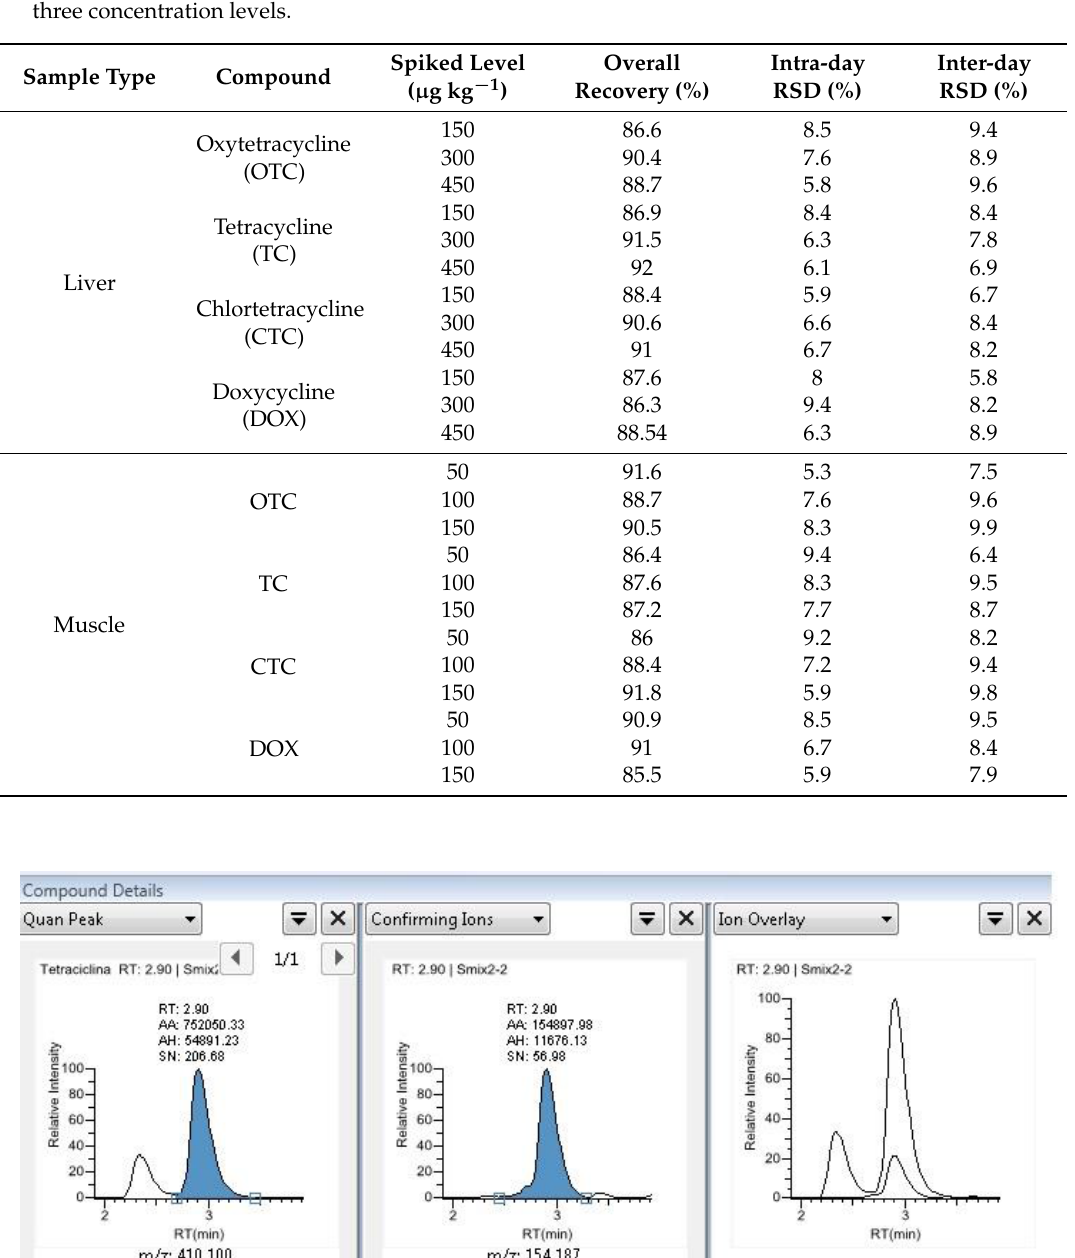
Table 1. Accuracy and precision of the method for tetracyclines in spiked bovine samples analyzed at three concentration levels.